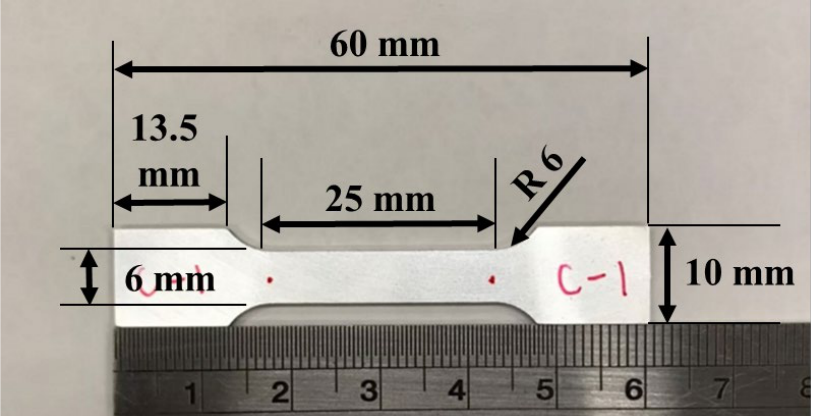
Figure 2. Geometry of dog-bone-like tensile test specimens of the 3D-printed Scalmalloy, the size and geometry of the sample is comparable to the ASTM E8 standard, but the length of grip section is shorter.